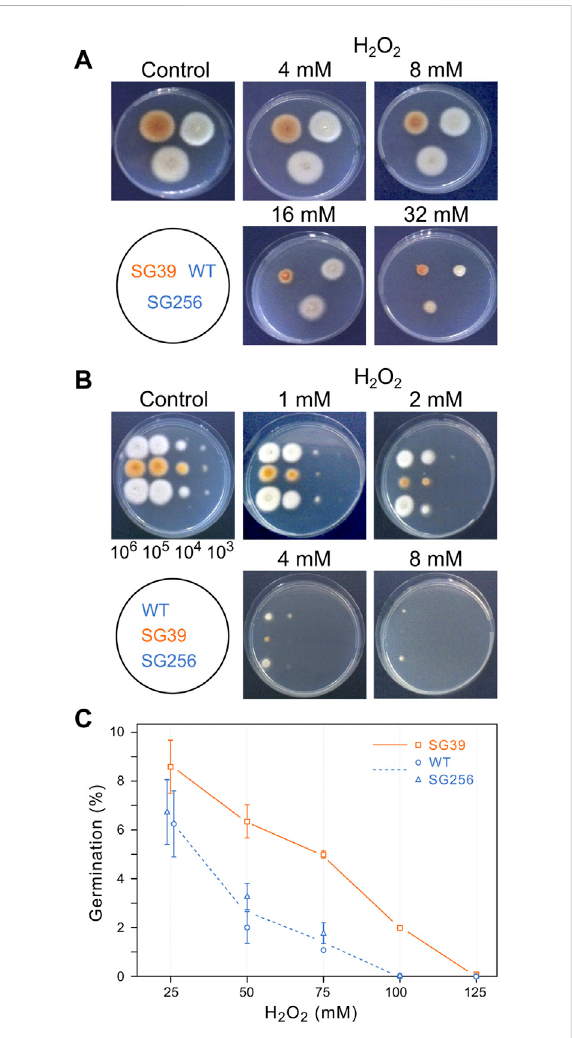
FIGURE 5 Effect of hydrogen peroxide on growth of the wild type (WT), carS mutant (SG39), and the complemented mutant (SG256). (A) Growth of surface colonies on media with different H 2 O 2 concentrations. Strains were grown for 4 days in DG agar mediumandthen1-mm 2 piecesofmyceliaweretransferredtoDG agar with the indicated H 2 O 2 concentrations. Pictures were taken after 3 days of cultivation at 30 ° C in darkness. (B) Growth from drops containing serial dilutions of spores of the three strains on DG agar with different H 2 O 2 concentrations, incubated for 3 days at30 ° Cinthedark. (C) Germinationofsporesexposedtohydrogen peroxide. Spores were incubated with different concentrations of H 2 O 2 for 30 min in agitation in darkness. Then the spores were washed twice and spread on DG plates to count number of